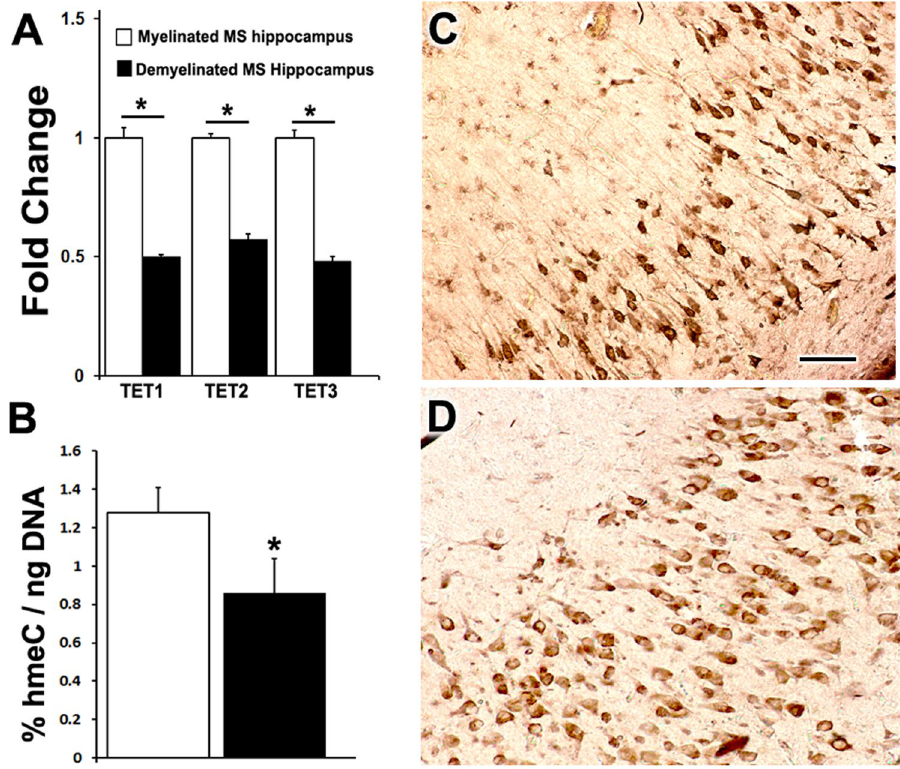
Figure 2. Demyelination in MS brains leads to lower expression of TET enzyme mRNA and hydroxymethyl residues. RT-PCR analysis shows significant decreases in mRNA levels of TET 1, TET 2, and TET 3 in demyelinated hippocampus (n = 4) compared to myelinated hippocampus (n = 4) ( A ). Compared to myelinated hippocampus (n = 8), demyelination (n = 7) led to a significant decrease in levels of hydroxymethyl content (hmC) ( B ). Immunohistochemistry analysis using a 5hmC antibody shows neurons as the major cell type with 5 hmC expression in myelinated ( C ) and demyelinated hippocampus ( D ). Scale Bars: C–D: 30 μ m; Error bars indicate + S.E.M.; * p < 0.05.